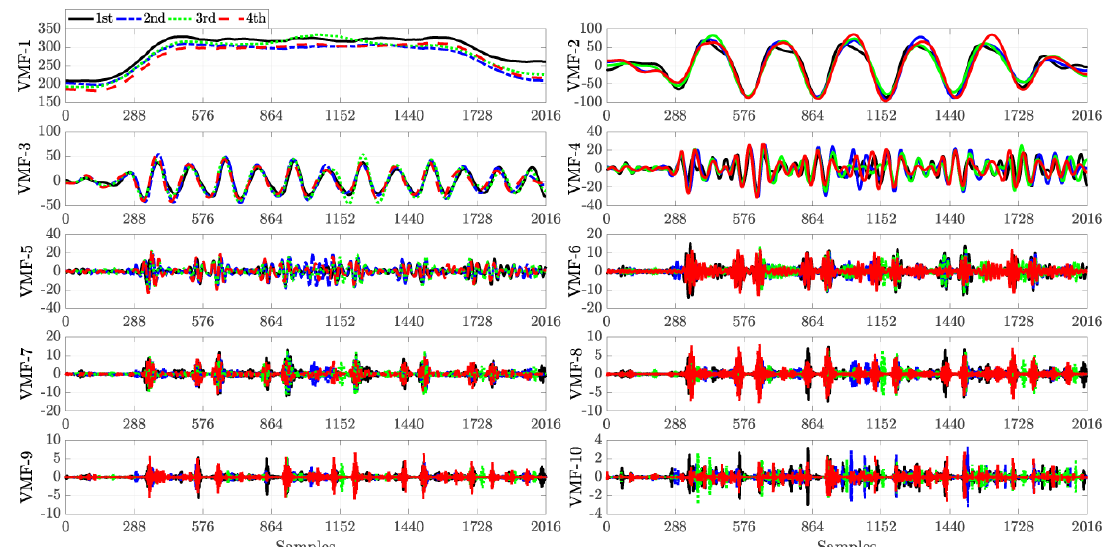
Figure 6. Weekly load profile decomposition using VMD ( k = 10). VMF, VMD